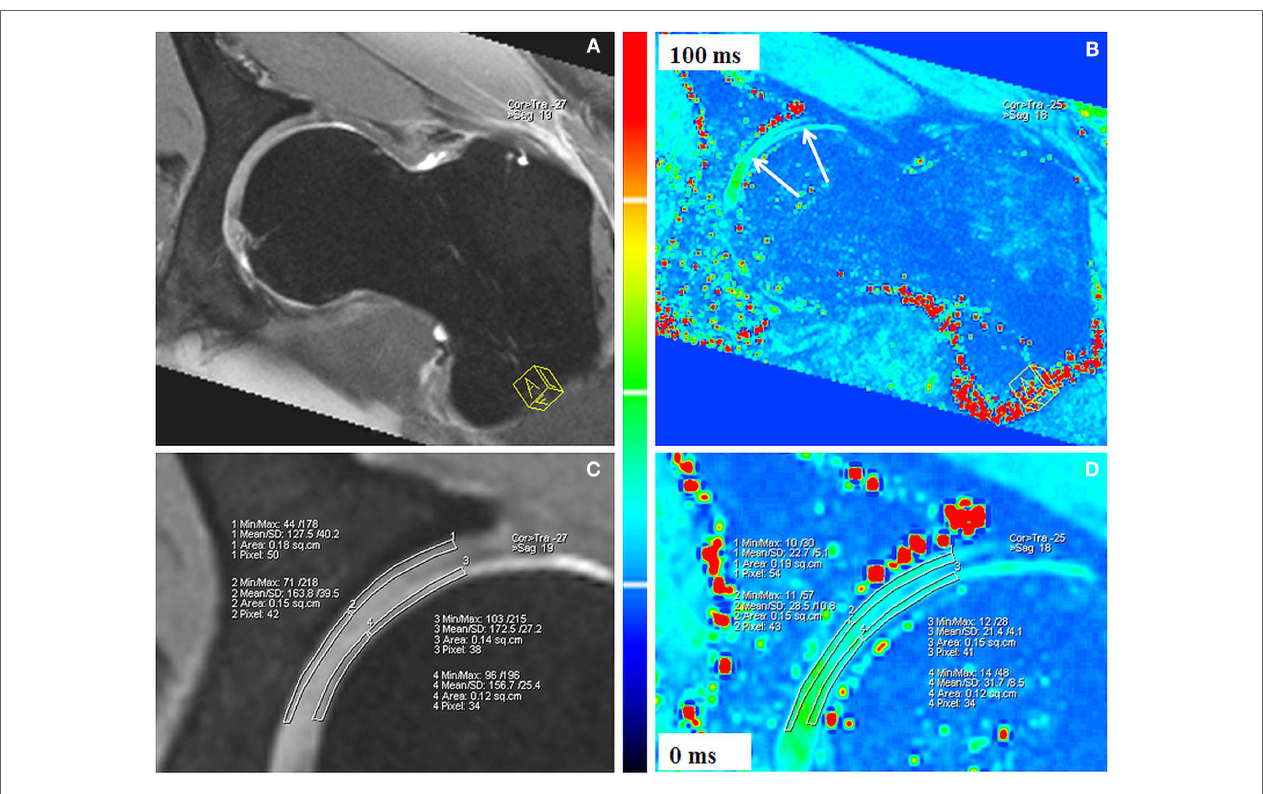
central acetabular cartilage, peripheral femoral cartilage, and central femoral cartilage. The DESS reformats (A,C) served as reference for accurate placement of the ROI squares within cartilage. T2* values are illustrated in a color scale (B,D) . Figure reprinted with permission